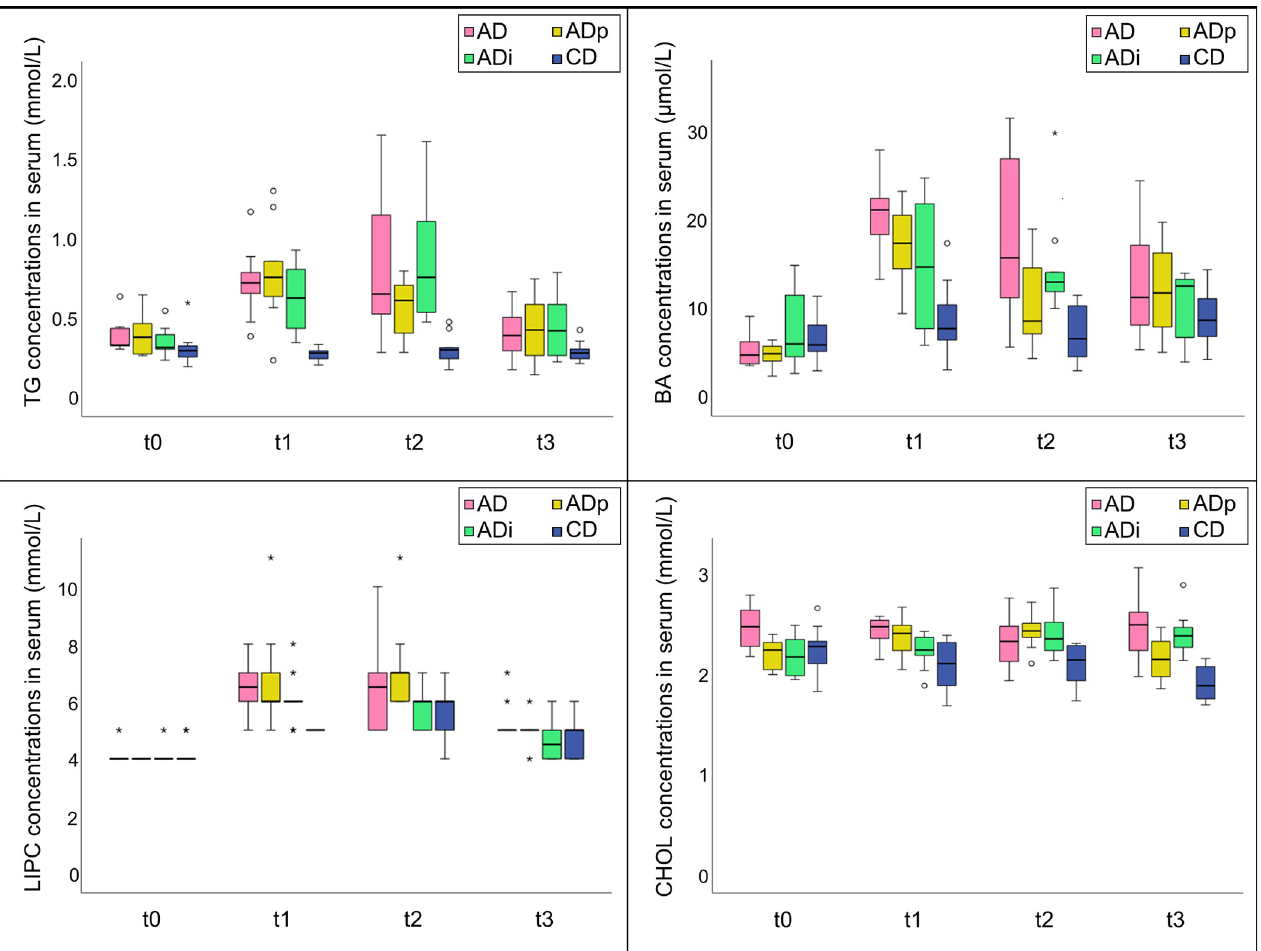
Fig 1. Triglycerides, bile acids, hepatic triglyceride lipase, and cholesterol concentrations in serum. Box plots show the concentration of TG, BA, LIPC and CHOL at the time point before the feed change (t0) and time points 1–3 months after the feed changes (t1–t3) for all feeding groups (AD, ADp, ADi, CD). TG, triglycerides; LIPC, hepatic triglyceride lipase; BA, bile acids; CHOL, cholesterol; AD, group fed atherogenic diet (n = 10); ADp, group fed atherogenic diet + pectin (n = 10); ADi, group fed atherogenic diet + inulin (n = 10); CD, group fed conventional diet (n = 10);˚ � , outliers and extreme values.